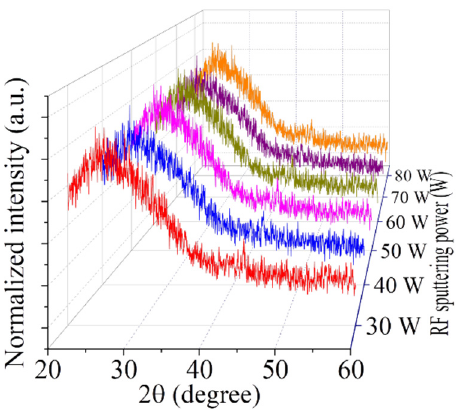
Figure 3. XRD patterns of the WO x films grown at different RF sputtering powers.